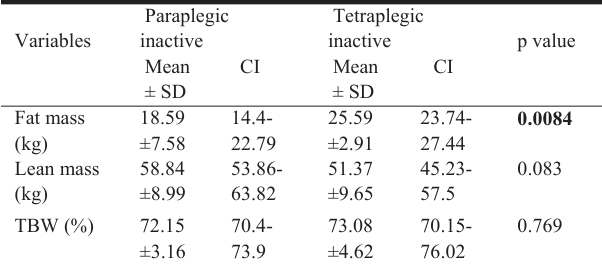
Table 5: BIA results comparing paraplegic inactive group and tetraplegic inactive